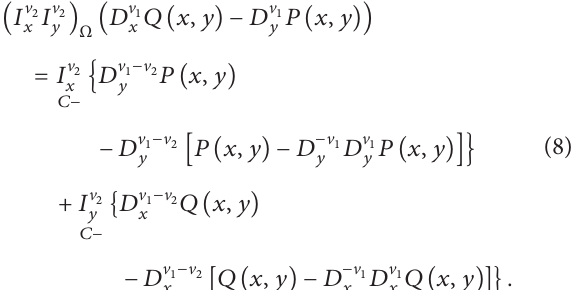
in Ω and 𝐶 , and the fractional continuous partial derivatives for 𝑥 and 𝑦 exist. If we consider 𝐷 1 to represent the first- order differential operator, then 𝐷 V represents the V -order fractional differential operator, 𝐼 1 = 𝐷 −1 denotes the first- order integral operator, and 𝐼 V = 𝐷 − V represents V -order fractional integral operator when V > 0 . Note that (𝐼 V 𝑥 𝐼 V 𝑦 ) Ω represents the V -order integral operator of curve surface in is the V -order integral operator in the the Ω plane. 𝐼 V 𝐶(𝐴𝐶 󳨀󳨀󳨀󳨀→ 1 𝐵) 𝐵 section of curve 𝐶 along the direction of 𝐴𝐶 𝐵 . 𝐼 V 𝐴𝐶 1 1 𝐶− is V -order fractional integral operator in the closed curve 𝐶 along counter-clockwise direction. Consider that boundary (𝑥) , 𝑦 = 𝜙 (𝑥) , 𝑎 ≤ 𝑥 ≤ 𝑏 or 𝐶 is circled by two curves 𝑦 = 𝜙 1 2 (𝑦) , 𝑥 = 𝜓 (𝑦) , 𝑐 ≤ 𝑦 ≤ 𝑑 , as shown in Figure 𝑥 = 𝜓 1 2